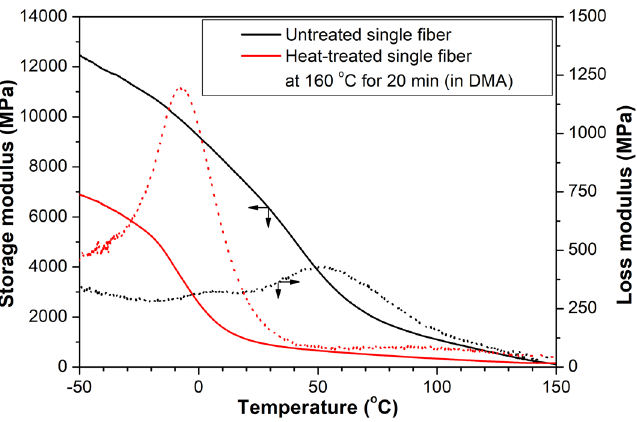
Figure 3. Storage and loss modulus of the untreated and the heat-treated (160 °C, 20 min) single fibers.